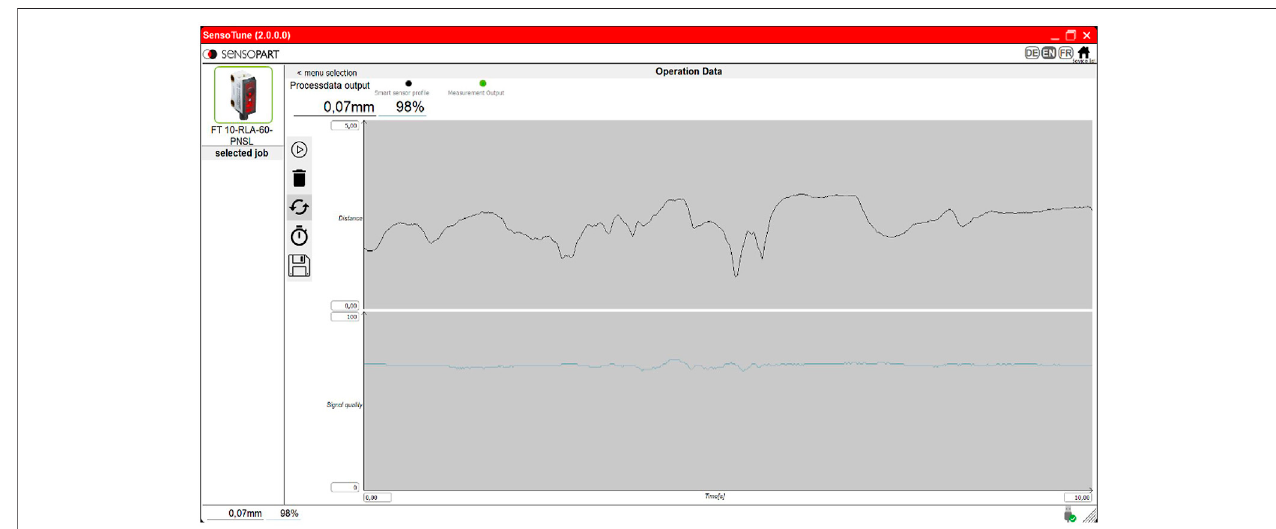
FIGURE2| Screenofthesensopartprogram:thenumericalvalueofthemeasureddistance andthequality ofthesignalareshown onthetopleft.Graphsofthese parameters as a function of time are shown in the centre.